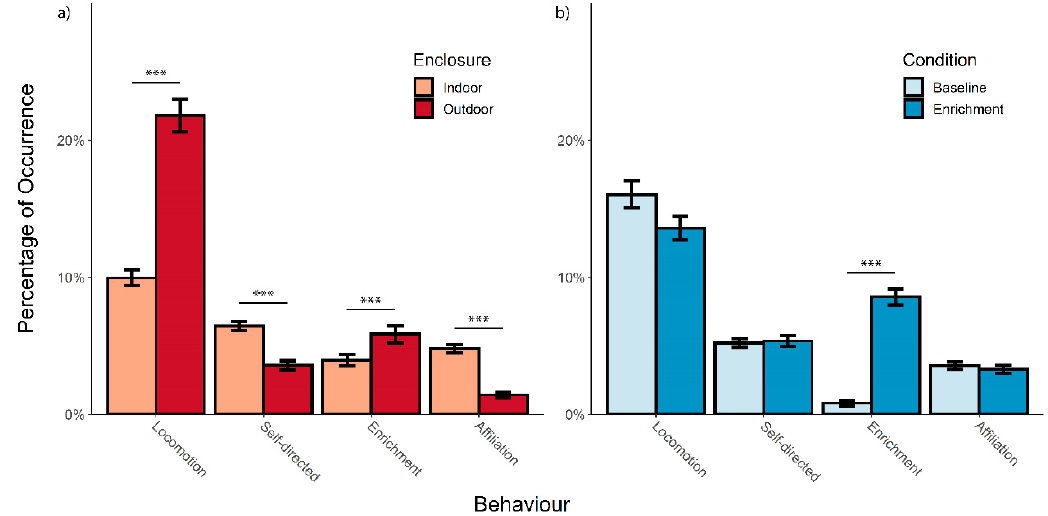
Figure 3. The percentage of occurrence ( ± SEM) for each behavioural category based on the ( a ) enclosure type and ( b ) enrichment provisioning. *** p < 0.001.